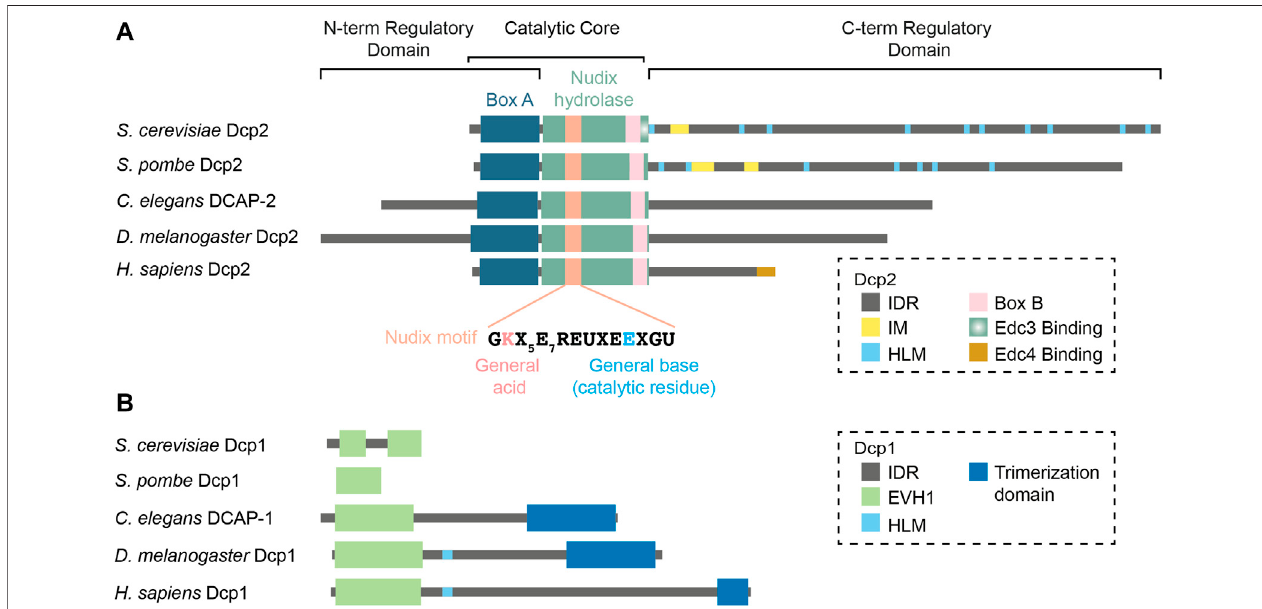
FIGURE 1 | Domain organization of the decapping holocomplex in various organisms. The decapping holocomplex is composed of Dcp2 and Dcp1. (A) Dcp2 is the catalytic subunit that contains the catalytic core composed of the Nudix hydrolase domain and Box A. The N- and C-terminal ends are regulatory domains mainly composed of intrinsically disordered regions which vary in length and sequence in different species. (B) Dcp1 is the main activator of Dcp2 and is characterized by a conserved EVH1 domain. Metazoan Dcp1 acquires an intrinsically disordered extension in the C-terminus and can form a trimer. Abbreviations: IDR = Intrinsically Disordered Region; IM = Inhibitory Motif; HLM = Helical Leucine-rich Motif; EVH1 = Enabled/Vasodilator-stimulated Phosphoprotein Homology